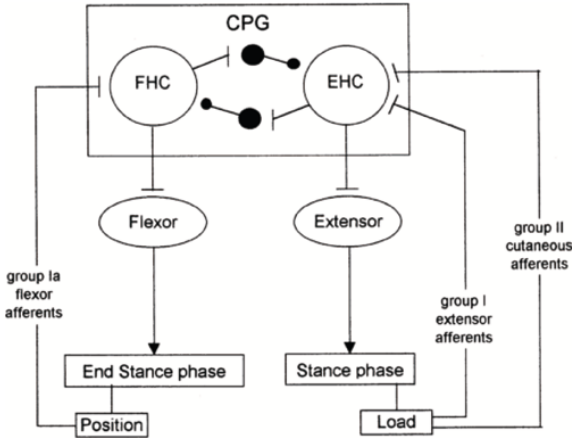
Figure 4. Model of the different pathways indicating how afferents can act on the central pattern generator (CPG) during the stance phase of